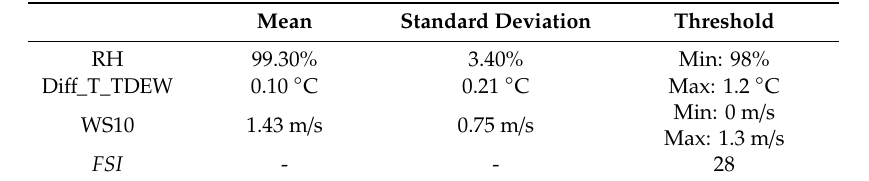
Table 6. Mean, standard deviation and thresholds selected for relative humidity, surface temperature / dew point depression and wind speed measured in fog condition and FSI threshold calculated using Youden’s index for Milano Linate.